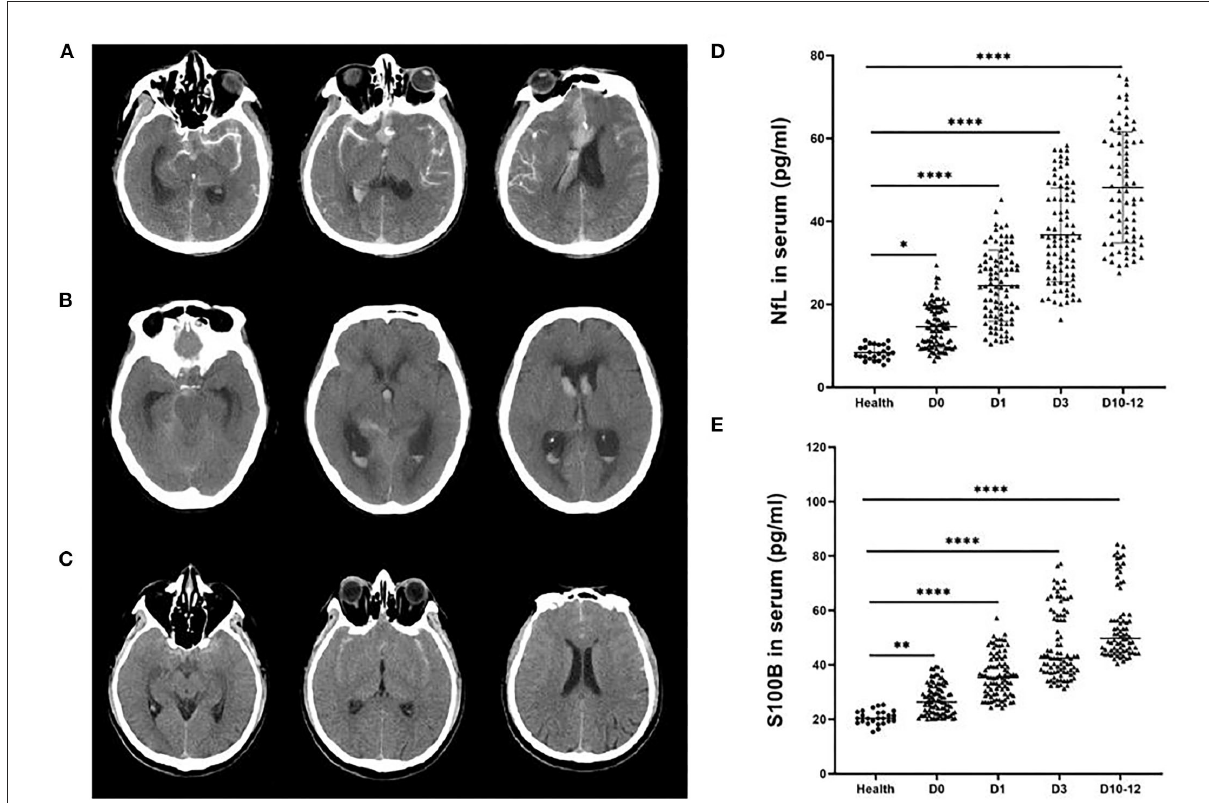
FIGURE1 Representative head computed tomography (CT) scan of patients with aneurysmal subarachnoid hemorrhage (aSAH). (A) The head CT scans of a patient with a Hunt-Hess grade IV aSAH with global and focal edema. (B) The head CT scans of an aSAH patient with a Hunt-Hess grade III with hydrocephalus. (C) The head CT scans of an aSAH patient with a Hunt-Hess grade II without edema or hydrocephalus. NfL (D) and S100B (E) levels were significantly elevated in the serum of aSAH patients compared with control patients at each period. Ultrasensitive Simoa and ELISA results showed significant differences between the health group and patients with different Hunt-Hess grades. *** P <